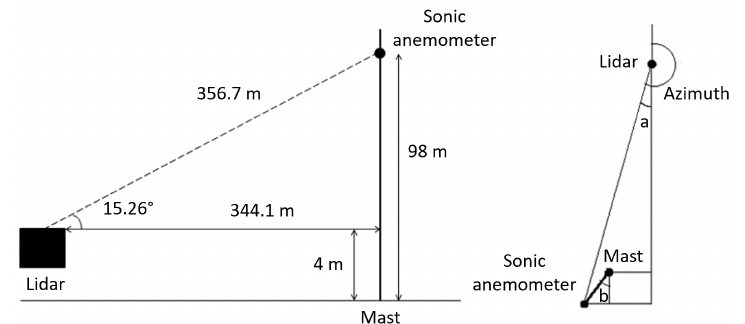
Figure 2. Schematic of the Lidar and mast positions. Left : side view of the setup. The elevation angle is 15.26 ◦ ; Right : top view of the setup. Azimuth angle = 180 ◦ + a, a = 6.86 ◦ . To avoid backscatter from the sonic anemometer, the Lidar azimuth was set to 186.94 ◦ , pointing approximately 0.5m west of the sonic anemometer. The sonic anemometer is mounted on a 5m long boom at an angle b = 45 ◦